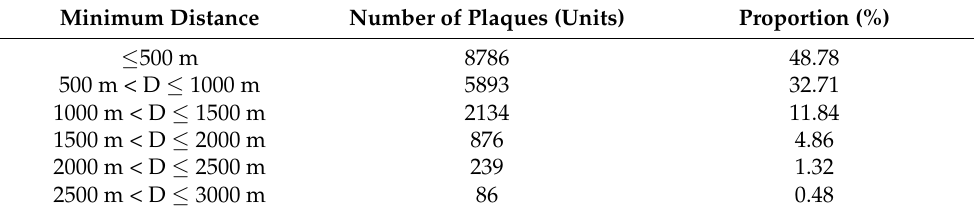
Table 4. Number of patches at different distances from rural settlements to rivers in Nanjing. Minimum Distance Number of Plaques